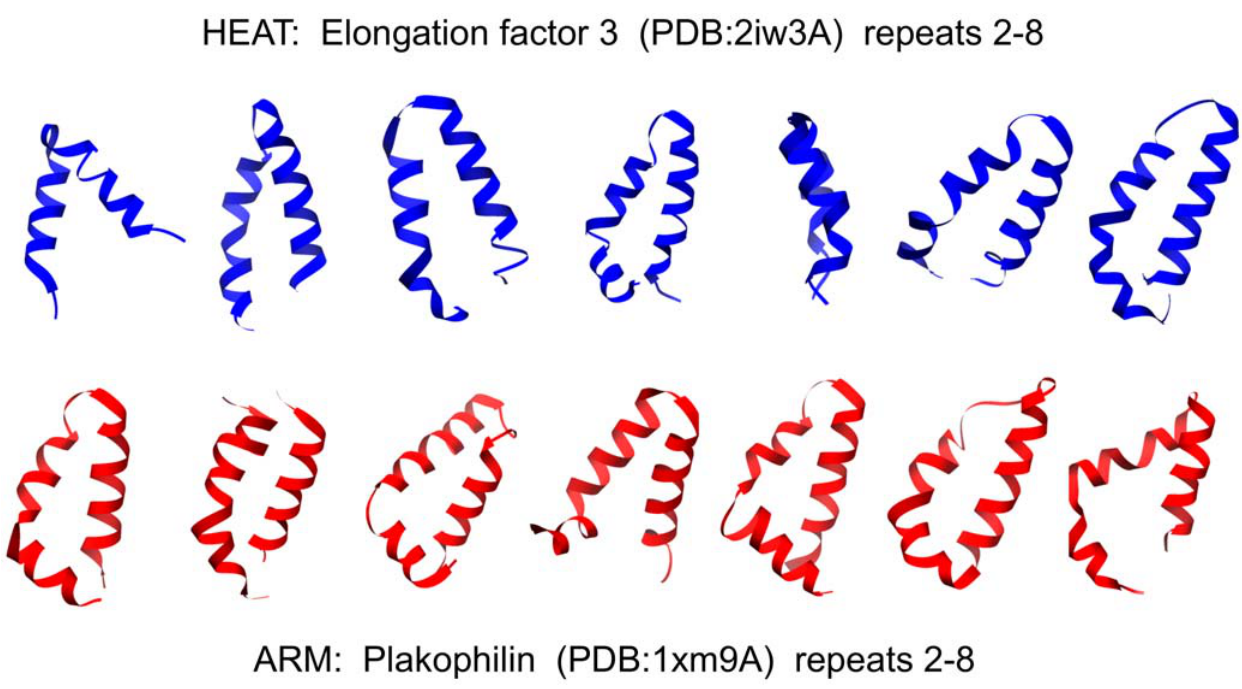
Figure 5. Sequence logos of typical and diverged ARM repeats. Comparison of ‘‘archetypal Armadillo’’ (top; PDB:1g3jA, 1ee4A, 1xm9A) and more divergent ARM (bottom; PDB: 1xqrA, 1ho8A, 1upkA, 2bnxA, 2fv2A, 3dadA) repeats. The logos were generated with WebLogo [34] from the indicated subsets of the Established Repeats data, with details as in Fig. 2.